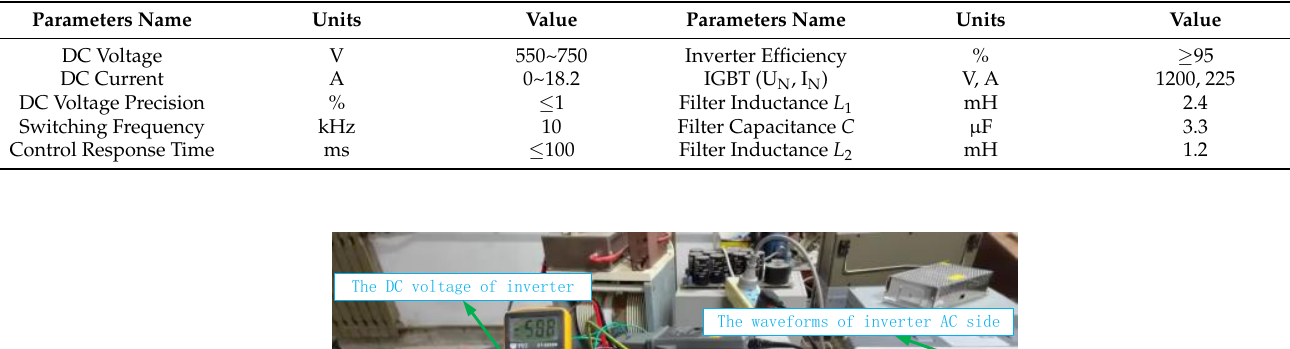
Table 3. The Experimental parameters.